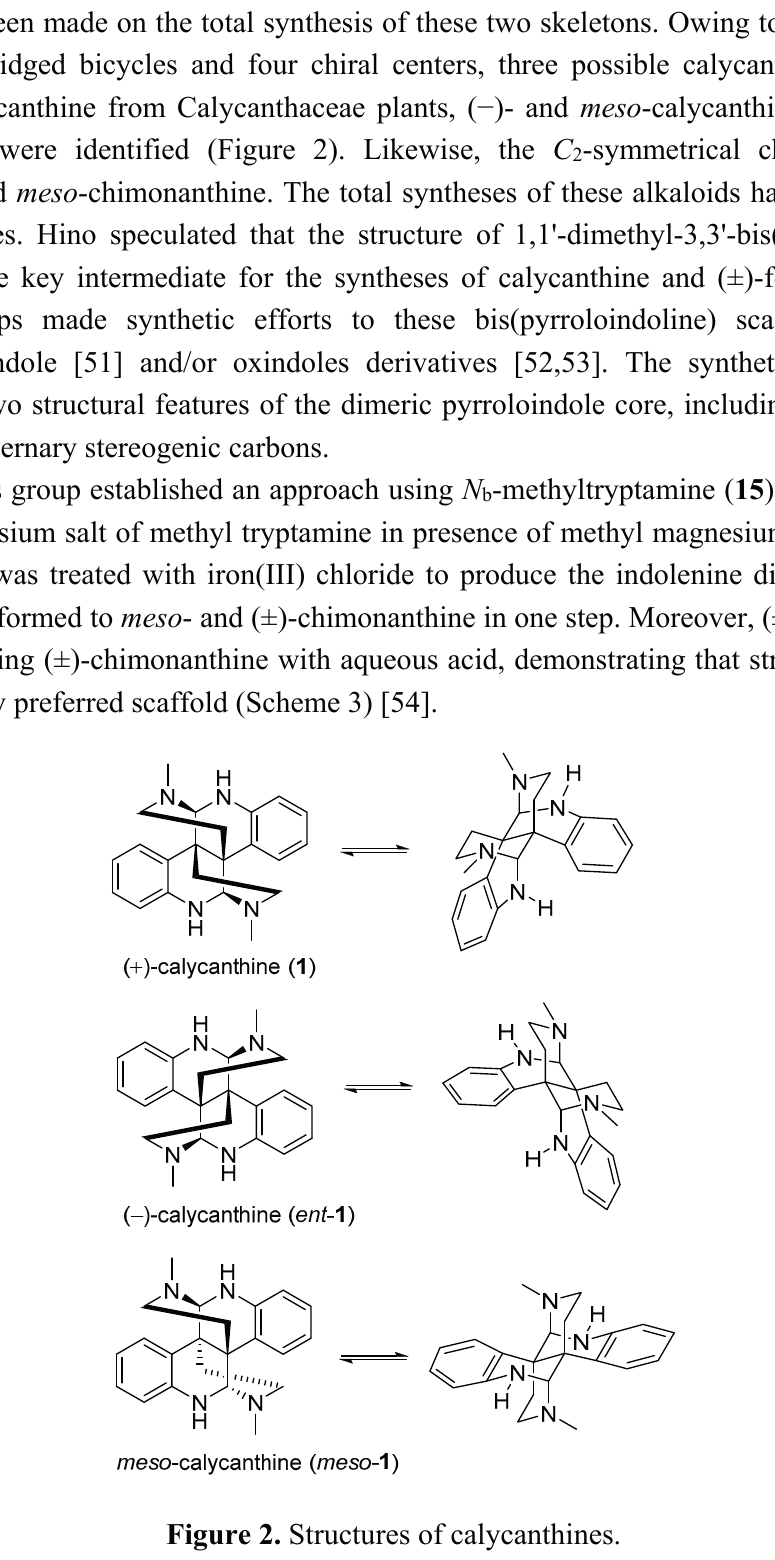
Figure 2. Structures of